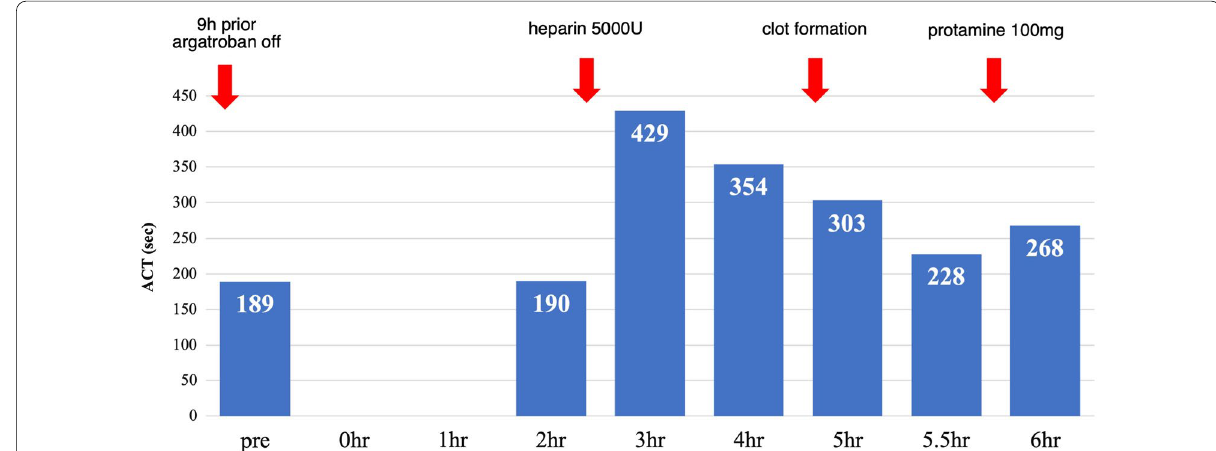
Fig. 1 Course of ACT and anticoagulation . Course of ACT and anticoagulation. Dual antiplatelet therapy was converted to argatroban preoperatively. The dose of heparin and the reaction of ACT were as usual. Clot formation was observed in the surgical field when the ACT was around 300 s. Even when sufficient protamine was used, the ACT was prolonged. ACT, activated clotting time